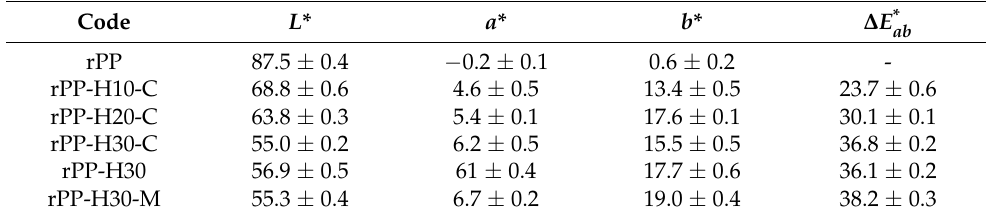
Table 6. Summary of the CIELEAB color coordinates of hemp fiber